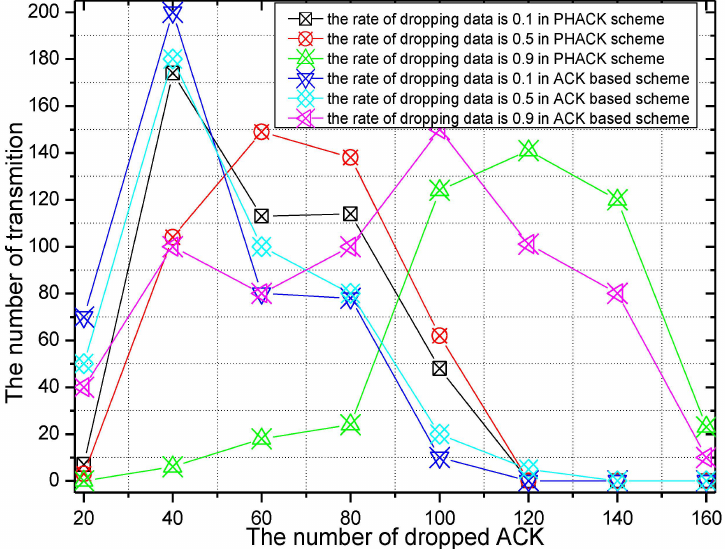
Figure 18. The number of dropped ACKs with different rates for dropping data.